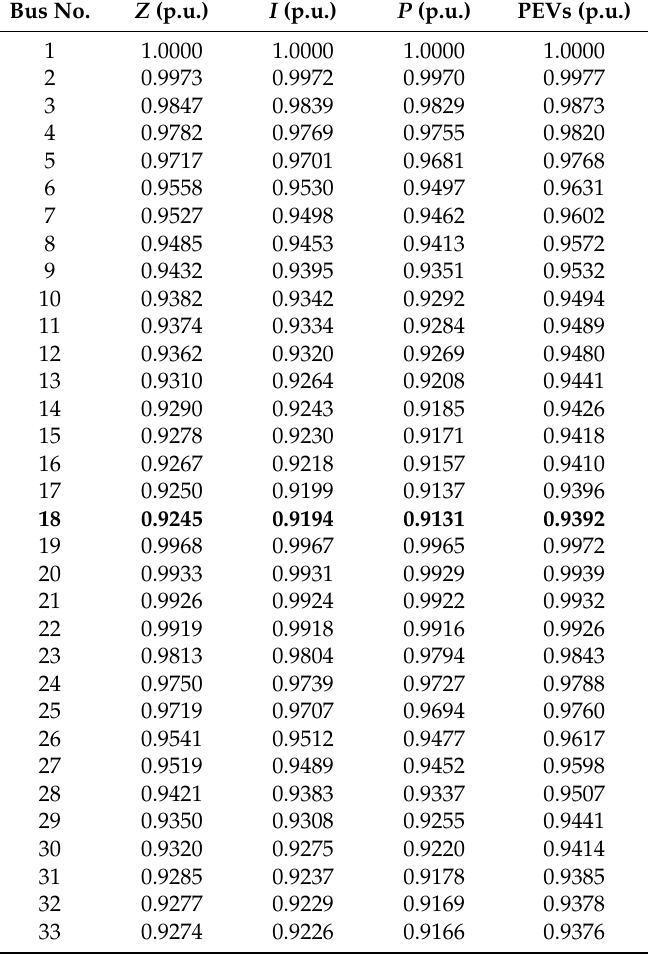
Table 5. Comparison voltage profiles of IEEE 33 bus test system load-flow results. Bus No. Z (p.u.) I